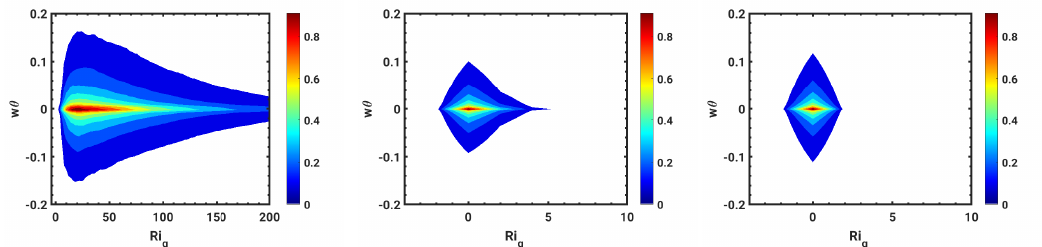
Figure 5. Joint probability of point-wise buoyancy flux normalized by N , B f ( x ) / N = w ( x ) θ ( x ) , and of gradient Richardson number Ri g ( x ) for runs rI, rII and rIII, respectively left, middle and right (see Table 1). Note the extended range of values for Ri g in the left panel. AP: Normalized or not, see Equation